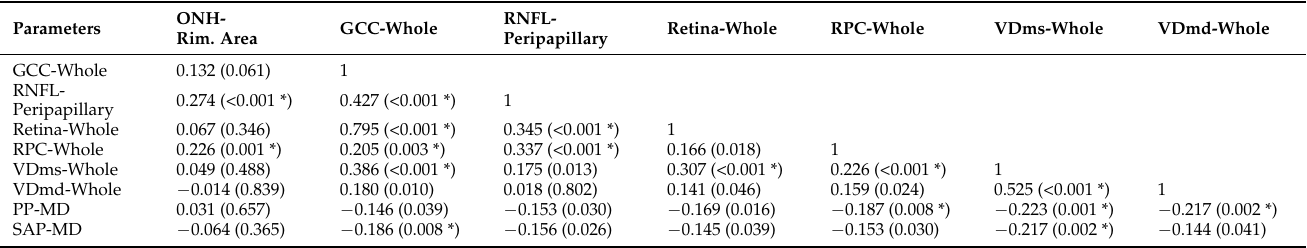
Table 5. Correlation matrix of generalized structural and vascular parameters of OCT and OCTA and functional parame- ters.